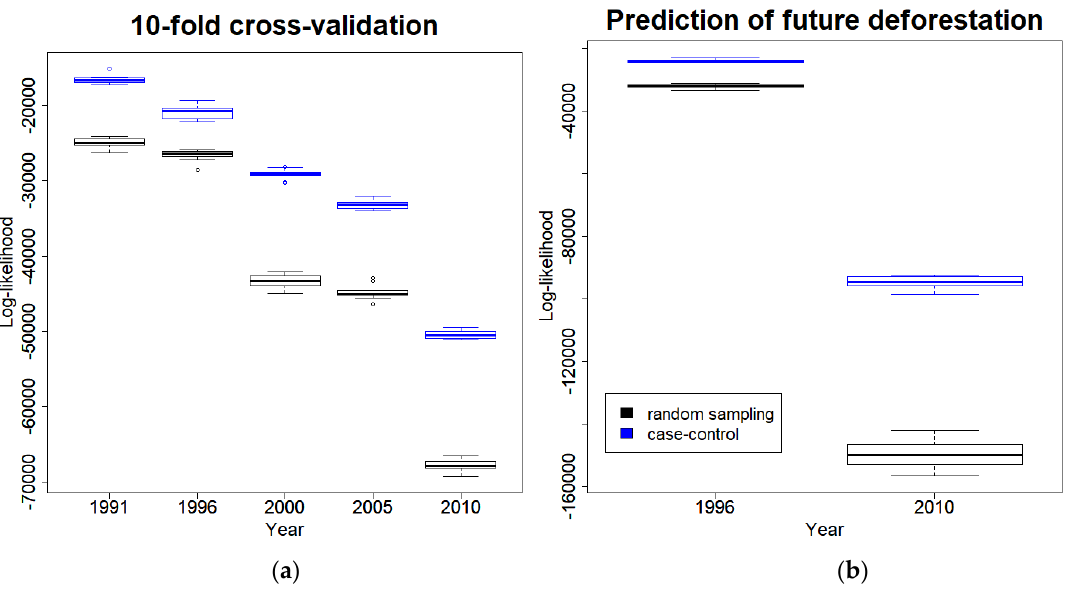
Figure 7. The random forest model fitted using case-control (CC) data and with adjusted probabilities (blue boxes) consistently had better performance when compared to the same model fitted to randomly sampled (RS) data (black boxes). Results from the 10-fold cross-validation exercise and the prediction of future deforestation are shown in panels ( a ) and ( b ), respectively. For each year, 10 different models were fitted to 10 different samples from the training data containing 100,000 pixels. Higher values for the log-likelihood indicate better predictive performance.